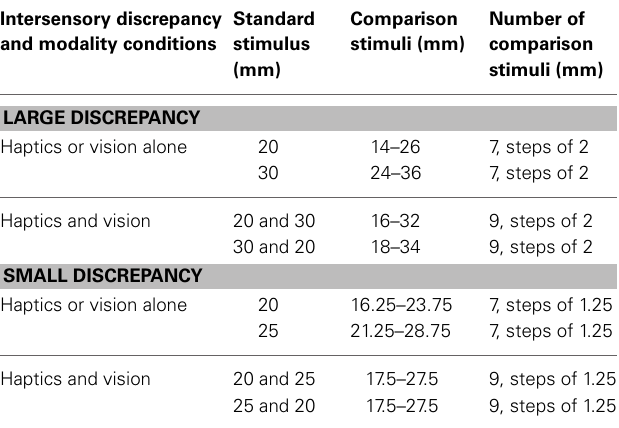
Table 1 | Length of comparison stimuli for each